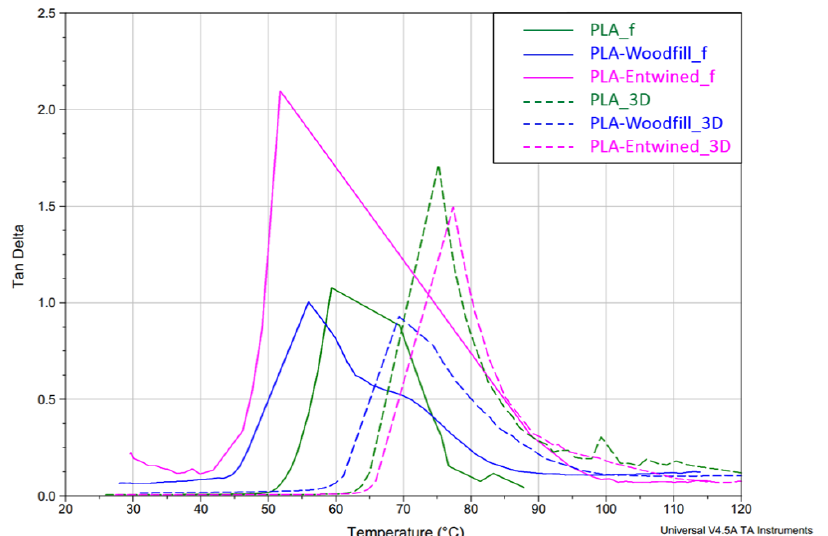
Figure 13. Tangent delta of PLA, PLA-Woodfill and PLA-Entwined samples before and after 3D printing vs. temperature at 10 Hz.